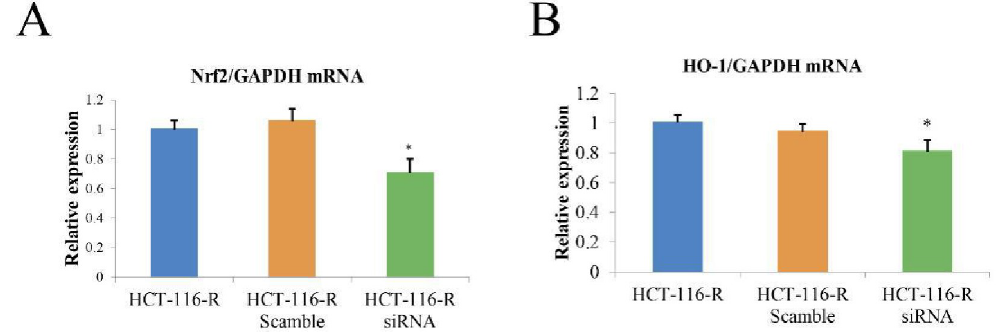
Fig 3. Knockdown of MIR4435 decreased the NRF2 and HO-1 mRNA levels related to oxidative damage. The relative NRF2 (A) and HO-1 mRNA (B) levels of HCT116R cells were analyzed by real-time PCR, and the results were normalized to the reference gene, GAPDH. The data are presented as the means ± SDs. � P <